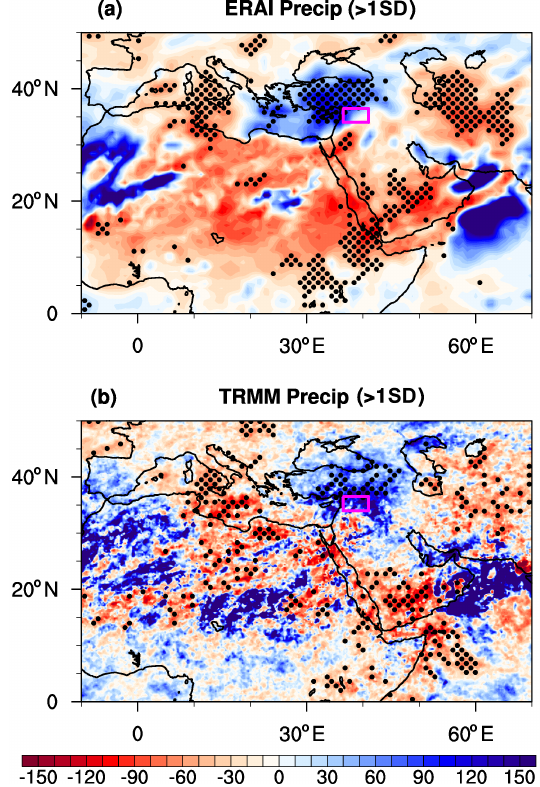
Figure 11. Composites of daily precipitation anomalies (shading; % with references to the climatology) from (a) the ERA-Interim and (b) TRMM for the days with Syrian DOD index (Aqua) greater than 1 standard deviation during MAM from 2003 to 2015. Areas significant at the 95% confidence level ( t test) are dotted.